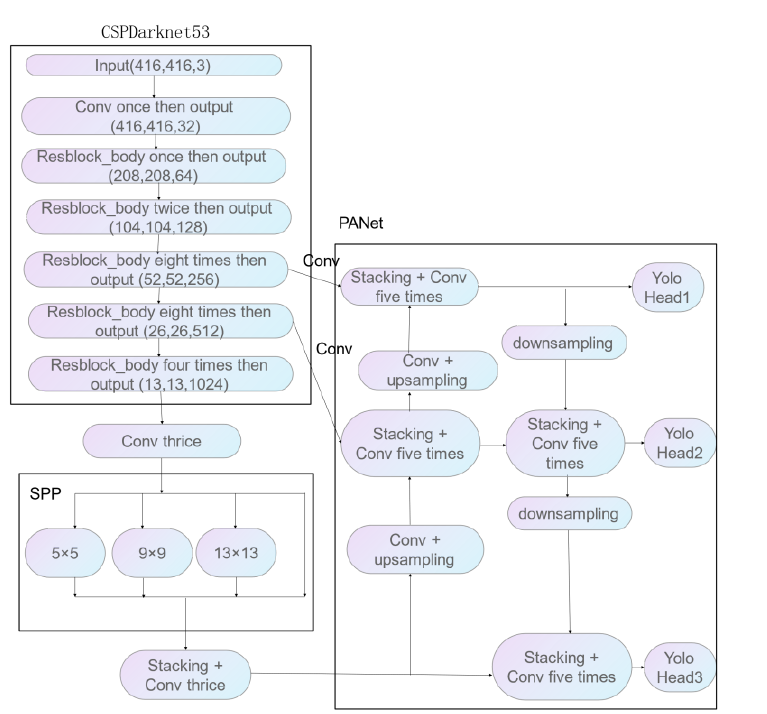
Figure 1. The architecture of YoloV4 network.